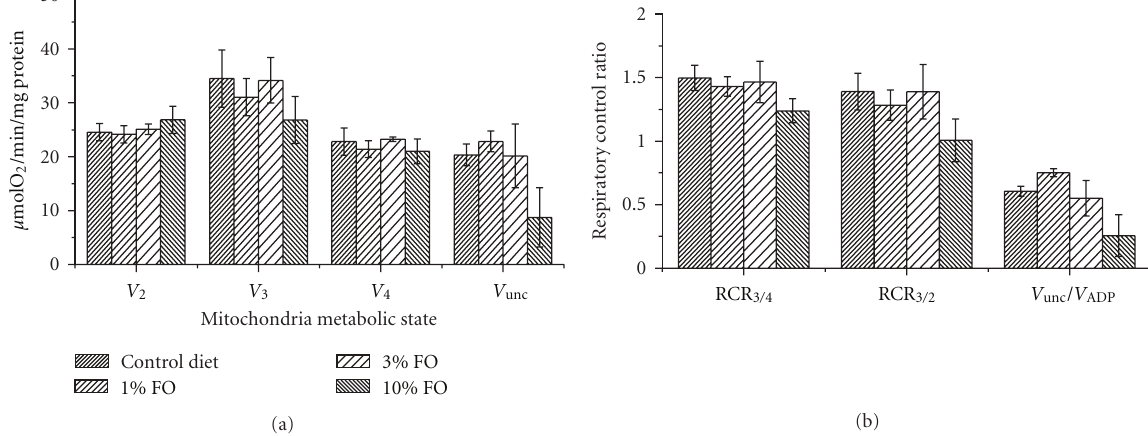
Figure 4: Omega-3 PUFA enriched diet does not a ff ect the sensitivity of brain mitochondria respiratory parameters to IsoKs. (a) Respiratory parameters measured in di ff erent metabolic states state 2 ( V 2 ), state 3 ( V 3 ), state 4 ( V 4 ), FCCP-stimulated respiration ( V unc ). Glutamate/malate was used as the substrate. IsoKs were added to mitochondria after the addition of substrate. (b) The dependence of the RCRs on omega-3 dietary content. The data are expressed in μ mol O 2 /min/mg protein and are the mean ± SEM, n = 6. Statistical significance in oxygen consumption between tested samples was determined by a two-sample t